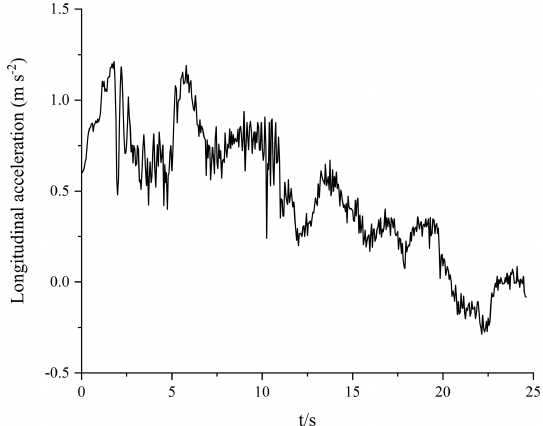
Figure 13. Longitudinal acceleration.